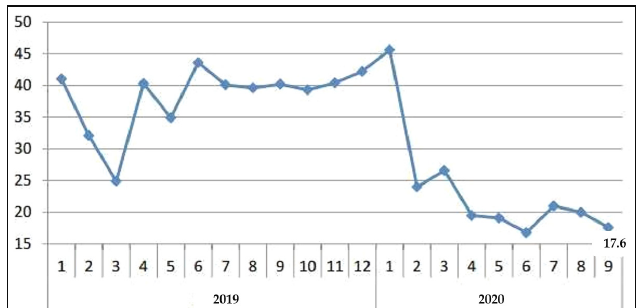
Figure 7. Weight of goods transported by airline (thousand tons) (Vietnam Logistics Report 2020).